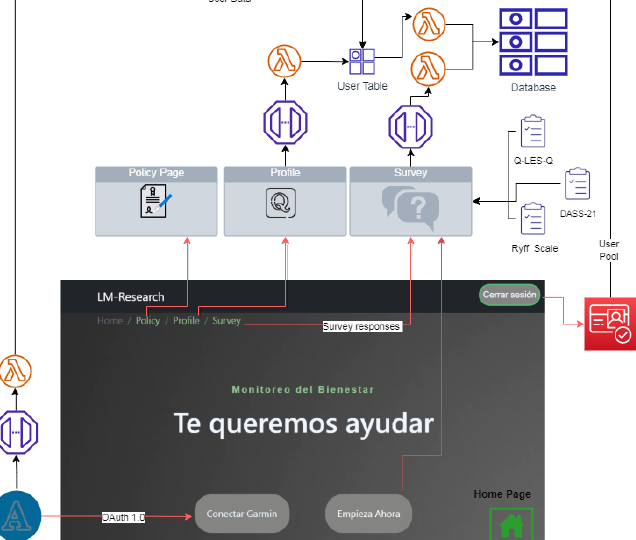
Figure 2. Pages and services of LM Research .